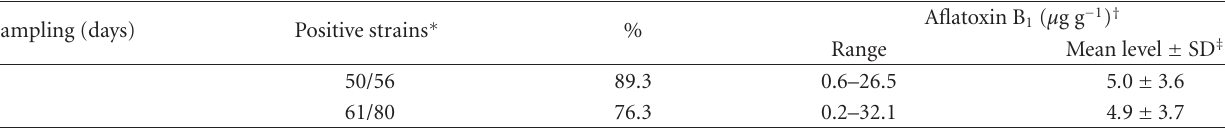
Table 4: Aflatoxin B 1 production by Aspergillus section Flavi strains isolated from brewer’s grain.